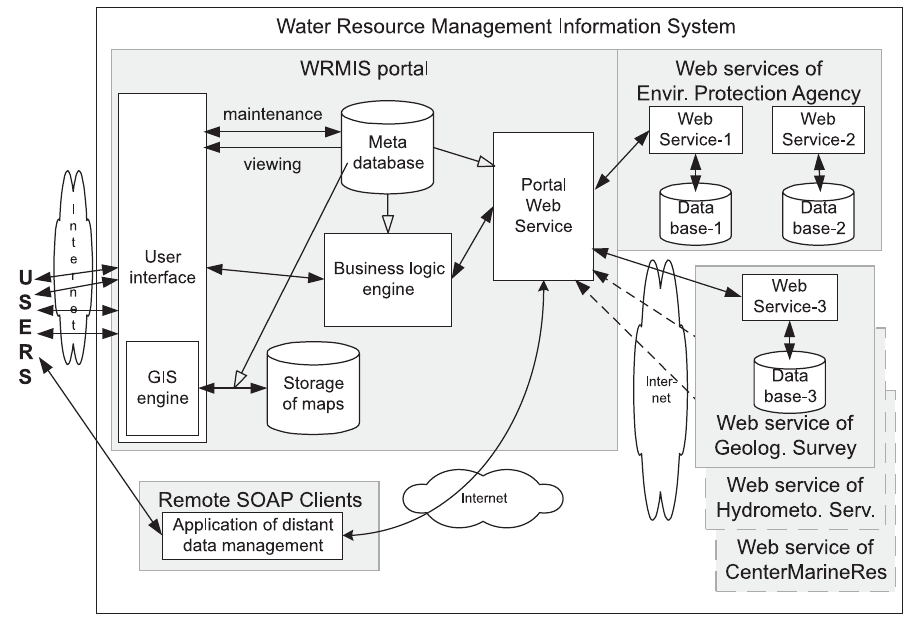
Fig. 1. Architecture of the water resource management information system